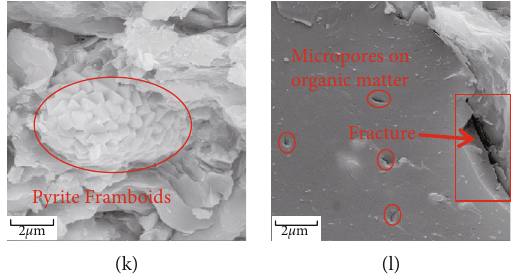
Figure 4: Pore types of shale gas reservoir in the Lower Shihezi group to the Taiyuan group of well Y1.